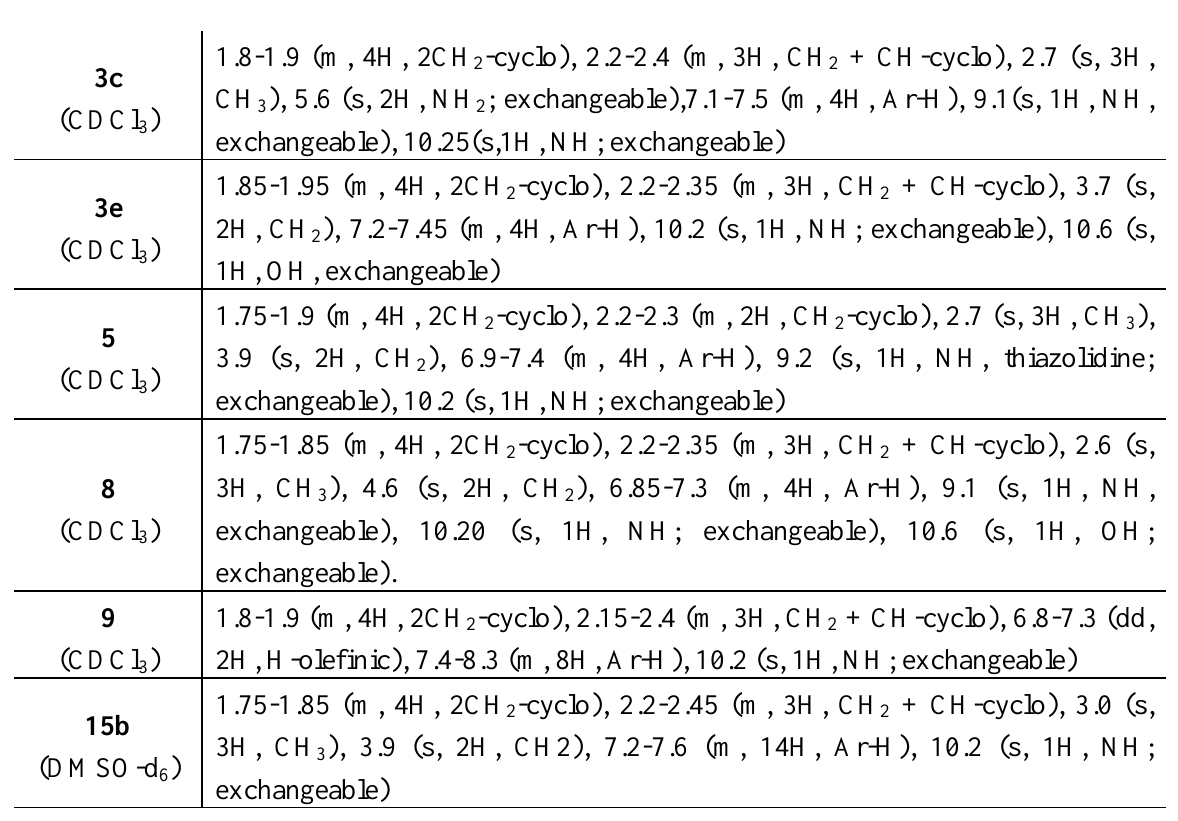
Table 4: Mass spectral data for some synthesized compounds Compd.